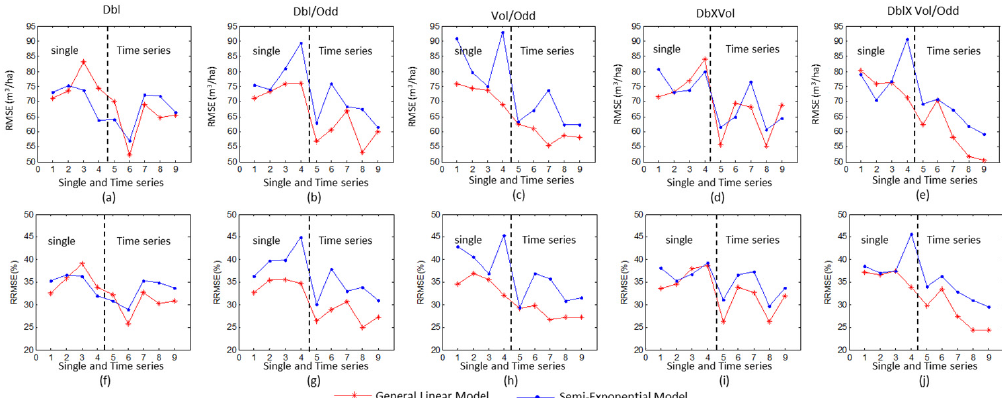
Figure 5. The RMSE ( a – e ) and RRMSE ( f – j ) between the measured and the estimated GSV retrieved by the selected independent variables using the GLM and the semi-exponential model. The numbers 1, 2, 3 and 4 in the X axis denote each single SAR image, and 5 to 9 denote the